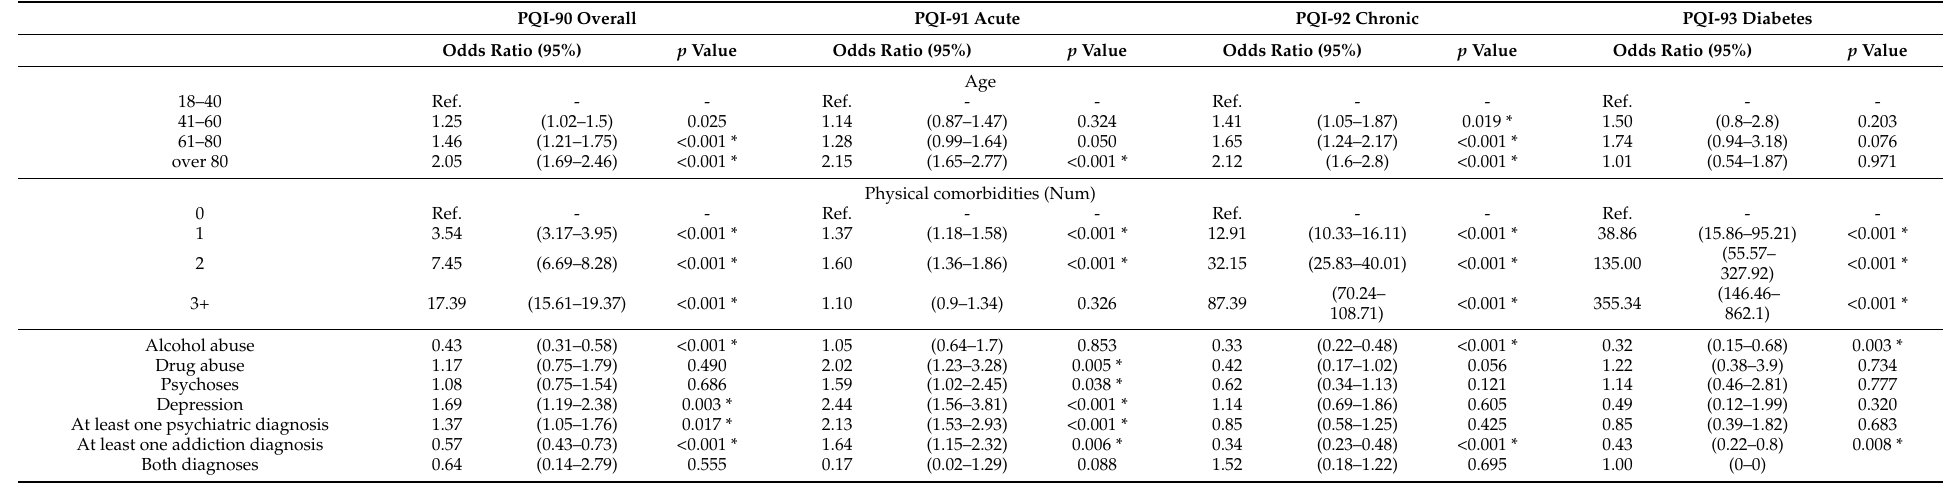
Table 4. Logistic regression for PQI in males.